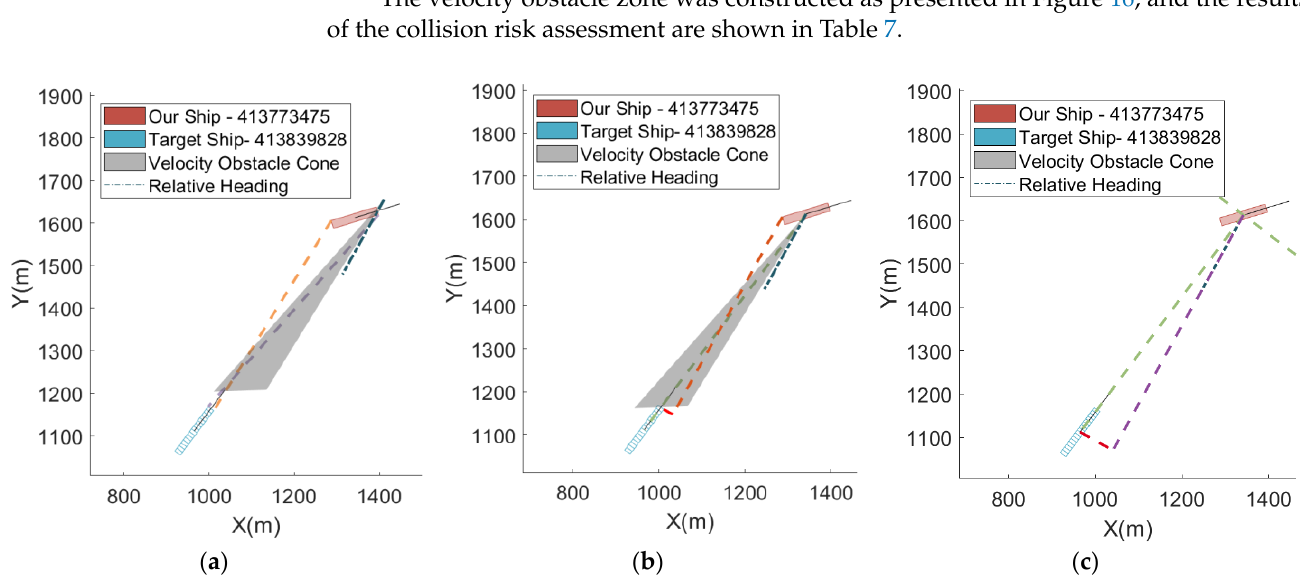
Figure 16. Comparison of DVOI/TVOI and CPA in Case 3. ( a ) The absolute velocity obstacle cone used to calculate DVOI, ( b ) the relative velocity obstacle cone used to calculate TVOI, ( c ) used to calculate DCPA and TCPA. Table 7. Risk assessment results of Case